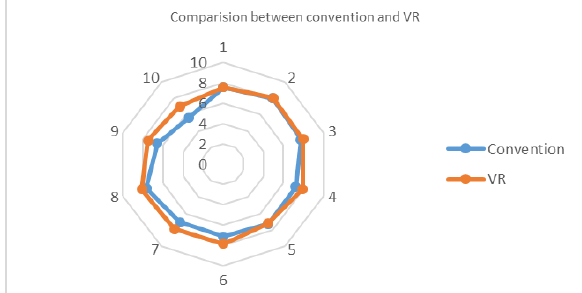
Table 1. Table of collected data from survey The responses from questions listed from number 1 to number 10 in table 2 are used to analyse data collection.